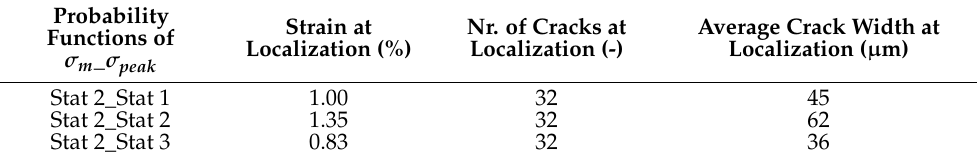
Table 6. Macroscopic strain at localization, average crack width, and degree of multiple cracking depending on the distribution function of the tensile strength. Data correspond to Figure 10. Probability Functions